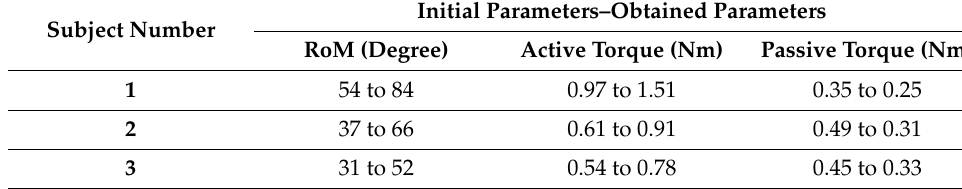
Table 6. Initial state of the wrist